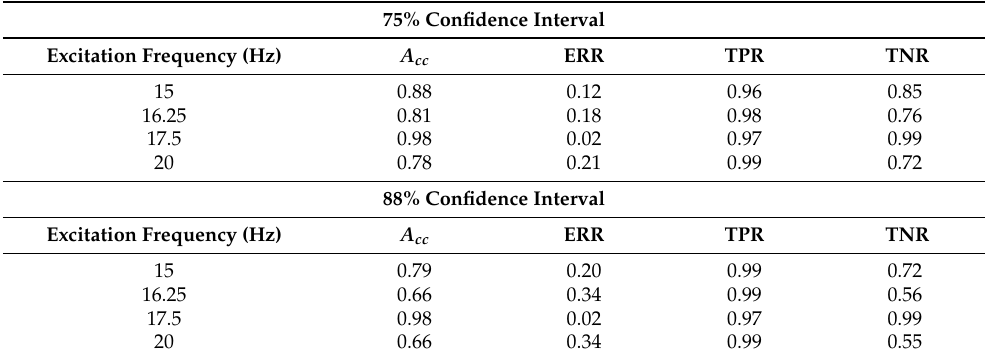
Table 6. Performance metrics of the unsupervised method, 75% and 88% confidence